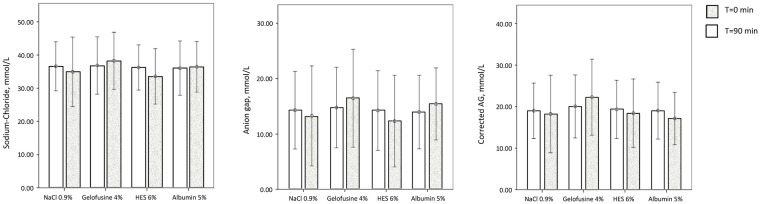
Sodium-chloride differences and (un)corrected anion gaps in various fluid types.(A) Mean (error bars represent +/- standard deviation) of sodium-chloride differences (Na+-Cl-) at baseline and after 90 minutes loading of various fluid types. For sodium-chloride difference: P = 0.032 T = 90 vs T = 0, P<0.001 for change between groups and P<0.001 for change in gelatine or albumin vs saline and hydroxyethyl starch (HES). (B) Mean of uncorrected anion gaps at baseline and after 90 minutes loading of various fluid types. P<0.001 for change between groups, P = 0.027 or lower for change in gelatine vs saline and hydroxyethyl starch (HES) and change in albumin vs saline and HES. P<0.001 for change in HES vs gelatine and albumin. (C) Mean of corrected anion gaps (AG) at baseline and after 90 minutes loading of various fluid types. P<0.001 for change between groups, P<0.001 for change in gelatine vs saline, hydroxyethyl starch (HES), and albumin.